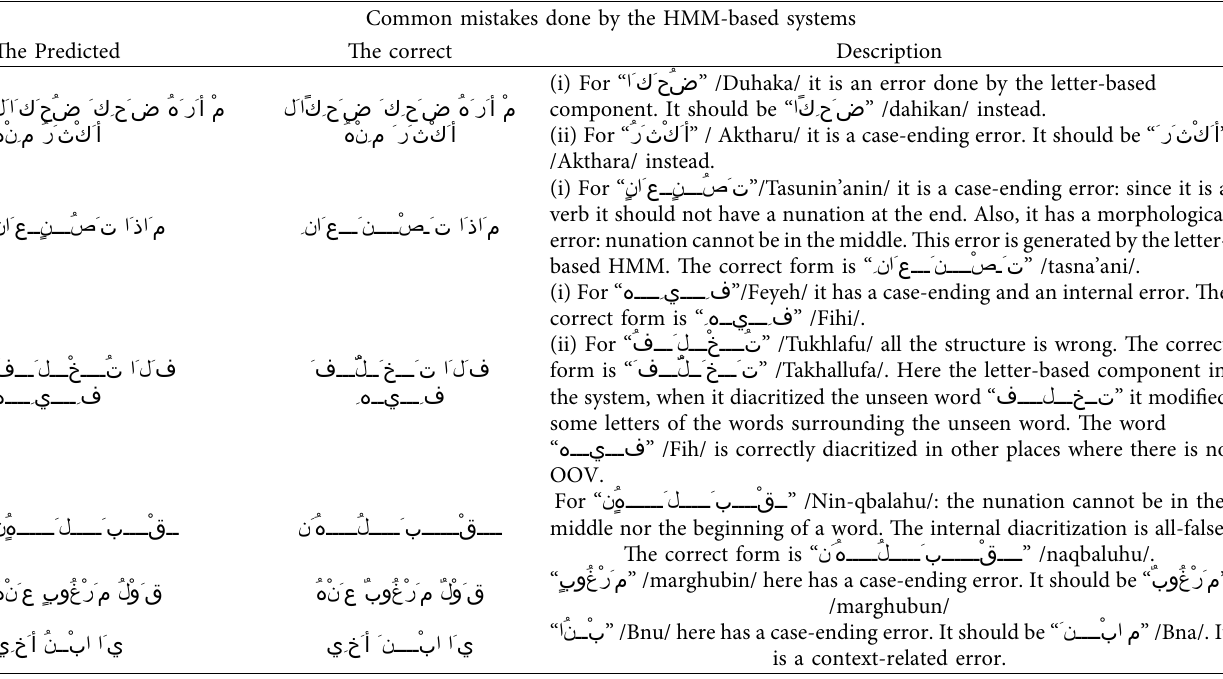
Table 6: Examples of some common mistakes done by the HMM-based systems Common mistakes done by the HMM-based